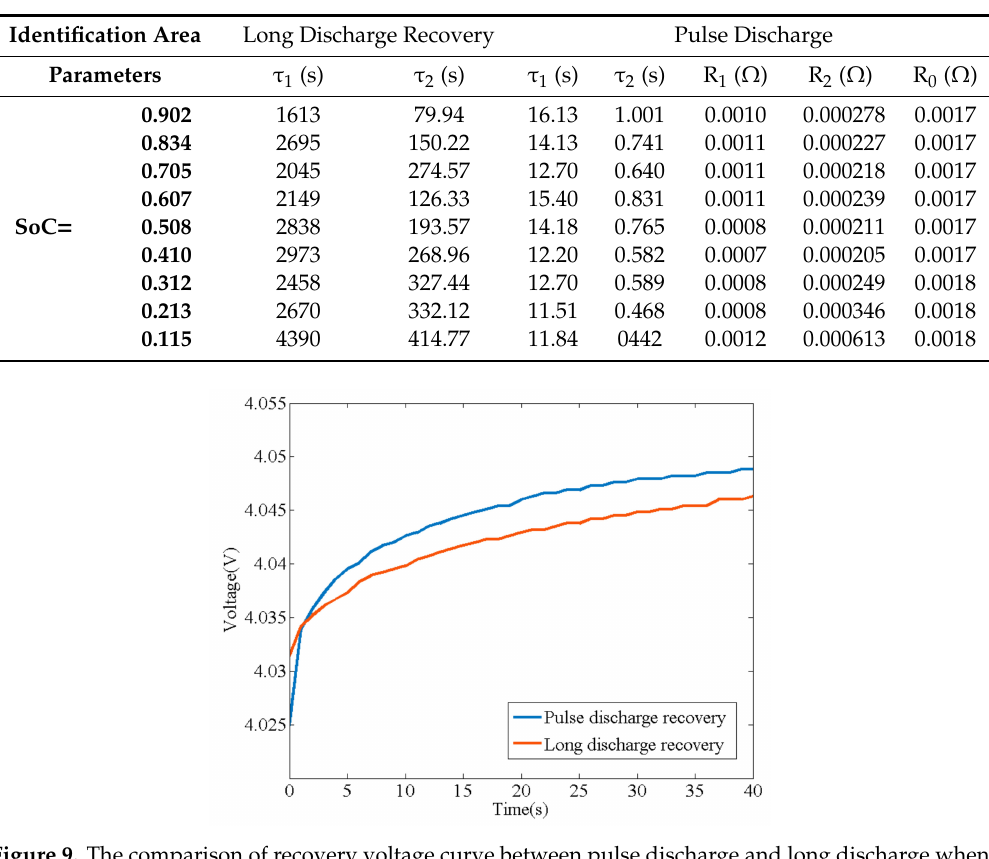
Figure 9. The comparison of recovery voltage curve between pulse discharge and long discharge when SoC = 0.902 (first 40